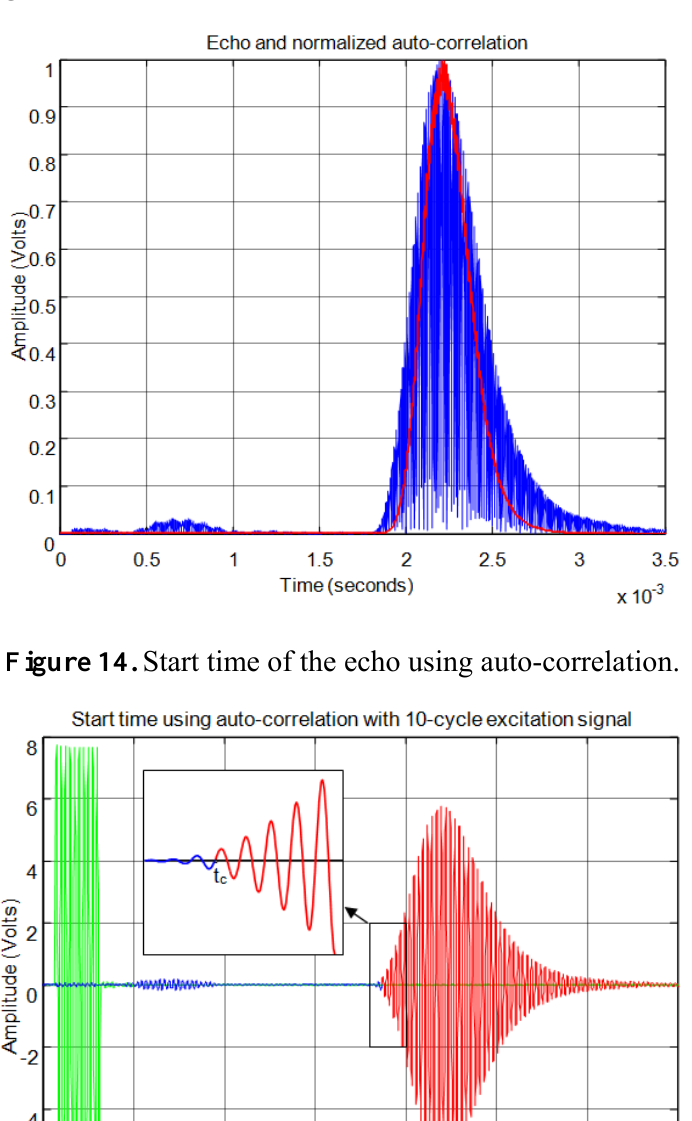
Figure 13. Normalized echo and maximum auto-correlation.